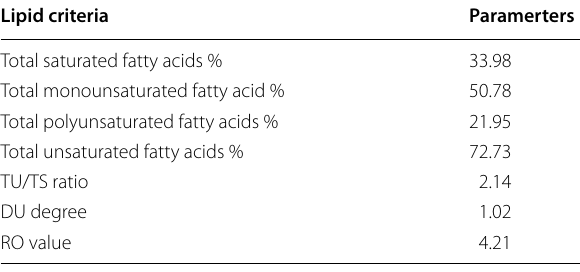
Table 6 Evaluation criteria o f Pseudochlorella pringsheimii